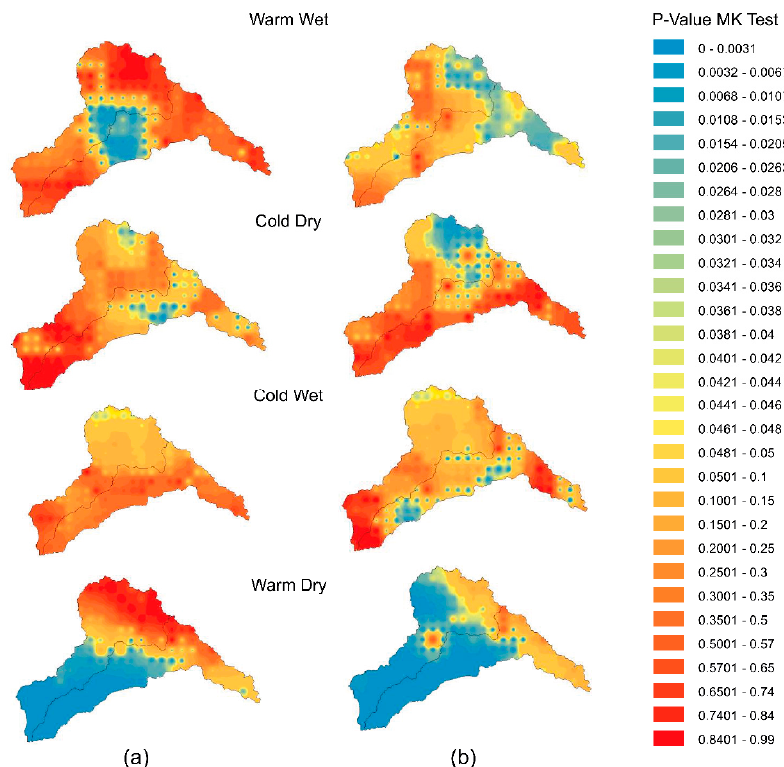
Figure 11. The p -values of the MK test for the best-correlated models for the period (2006–2099) for warm-wet, cold-dry, cold-wet and warm-dry for ( a ) Forcing Scenario of RCP 4.5 ( b ) Forcing Scenario of RCP 8.5. The blue and green shades are depicting that the Null Hypothesis of “no trend” is rejected.